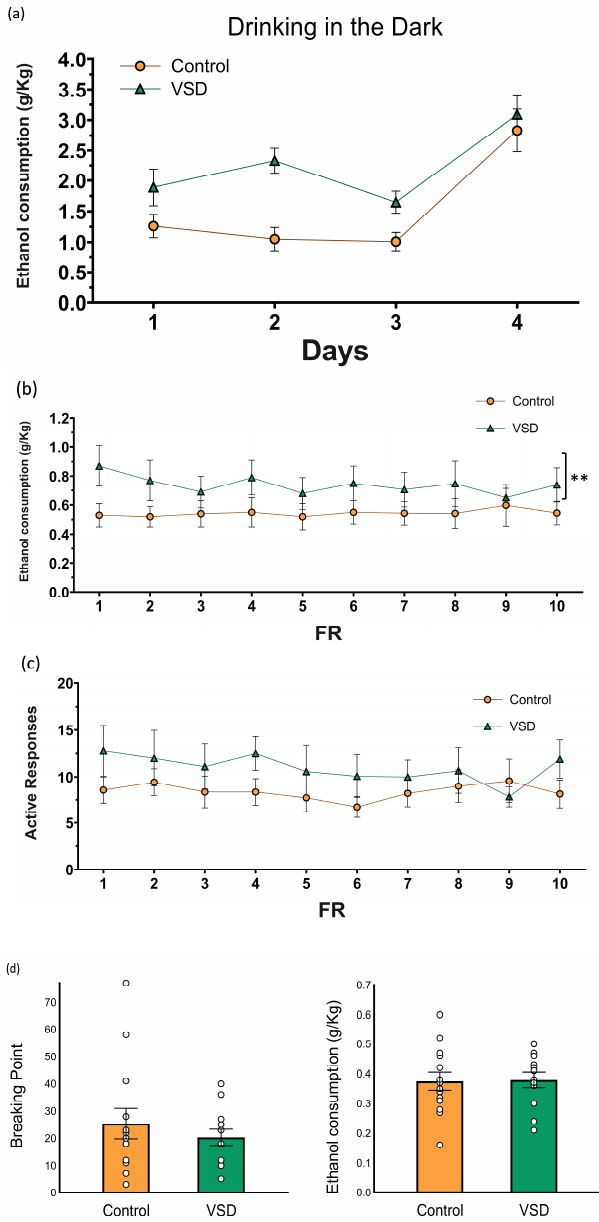
Figure 8. ( a ) Effect of Vicarious Social Defeat (VSD) on ethanol intake during Drinking in the Dark (DID). The dots represent means and the vertical lines ± SEM of the g/kg of ethanol at 20% consumed. ( b ) Oral ethanol Self-Administration (SA). The dots represent means and the vertical lines ± SEM of the volume of 20% ethanol consumption during FR1 (in g/kg) and the stress effect (F(1,24) = 6.928; p< 0.015). ** p< 0.01, significant difference in ethanol consumption with respect to the control group. ( c ) The number of active responses. ( d ) The columns represent means and the vertical lines ± SEM of breaking point values and the volume of 20% ethanol consumption (in g/kg) obtained during PR (control group, n = 14; VSD group, n =